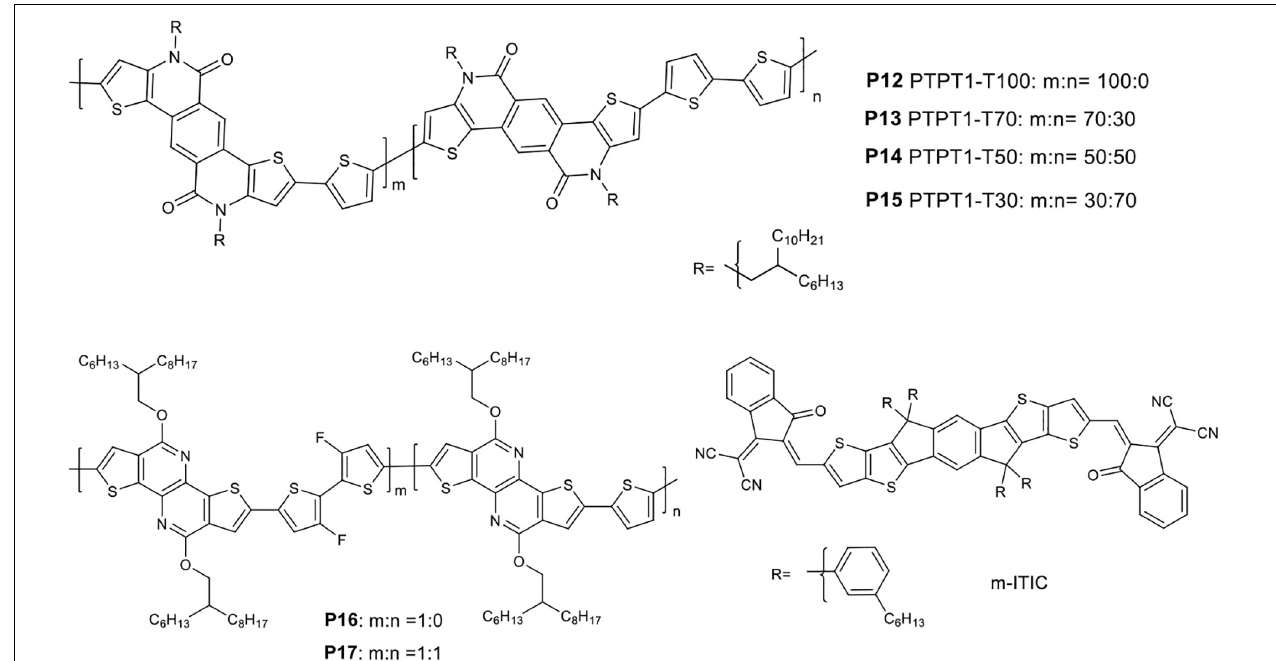
FIGURE 2 | Donor polymers containing lactam ring ( P12 – P17 ) and